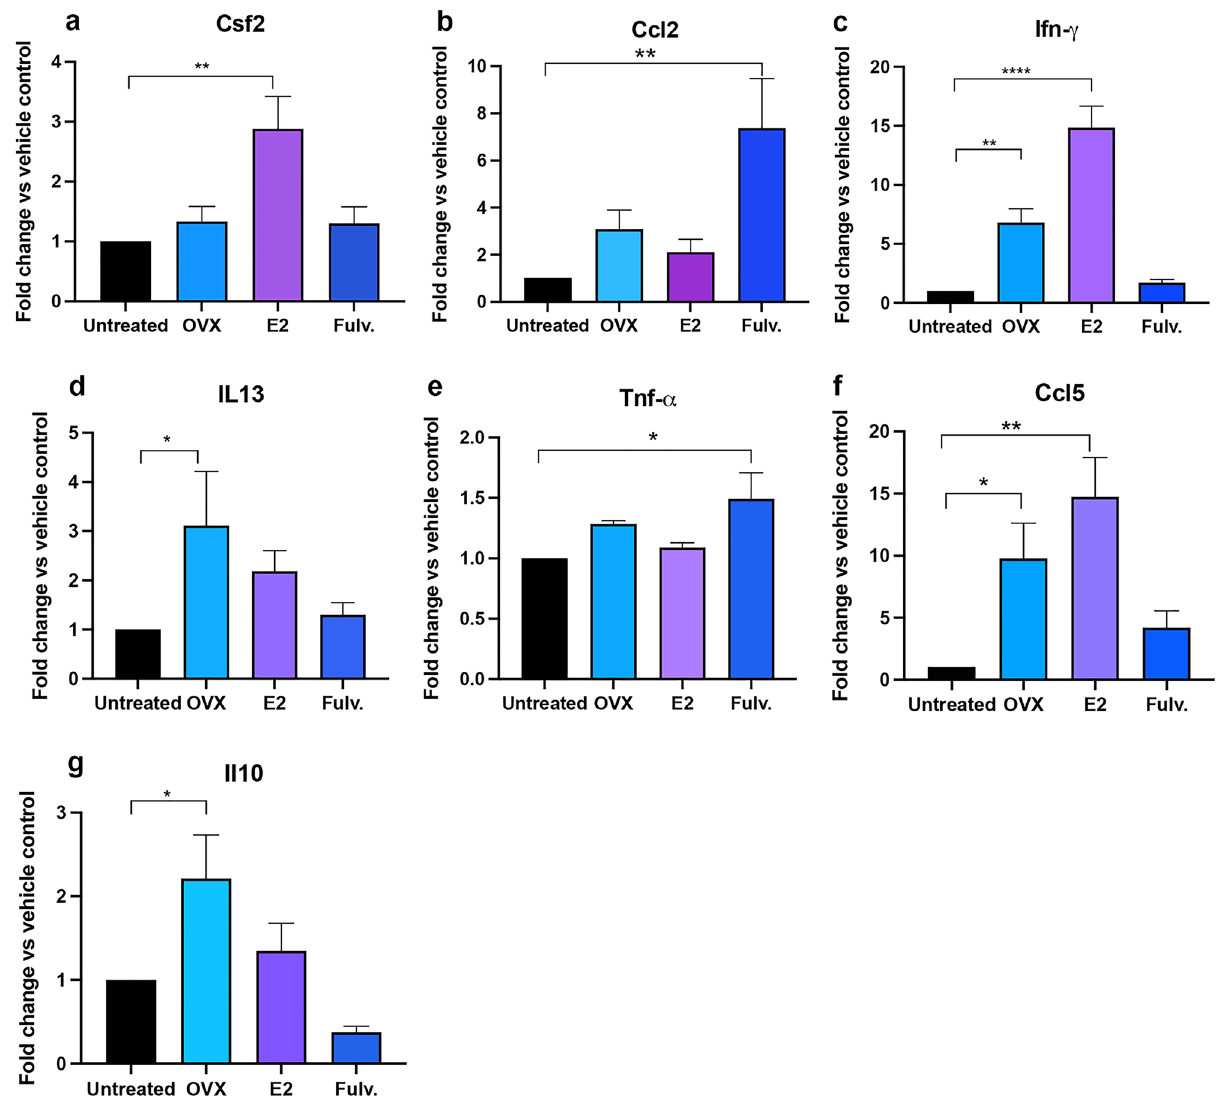
Figure 7. Effects of estrogen, oophorectomy and fulvestrant on transcript expression of myeloid specific cytokines in the mouse mammary epithelial cells. Mice were either untreated, ovariectomised (Ooph) or treated for 6 weeks with estrogen (E2) or Fulvestrant (Fulv). ( a ) Csf-2, ( b ) Ccl2, ( c ) Ifn-α, ( d ) IL-13, ( e ) Tnf-α, ( f ) Ccl5, ( g ) Il-10. Results are expressed percentage of immune cells (mean ± SEM). n = 4 biological replicates of n = 2–10 mice/group. Data was analysed using a Turkey multiple comparisons one-way ANOVA if confirmed Gaussian distribution, or Kruskal–Wallis multiple comparisons 1-way ANOVA if non-Gaussian. Statistically significant results are denoted with *p < 0.05, **p < 0.01, ***p < 0.001, ****p <